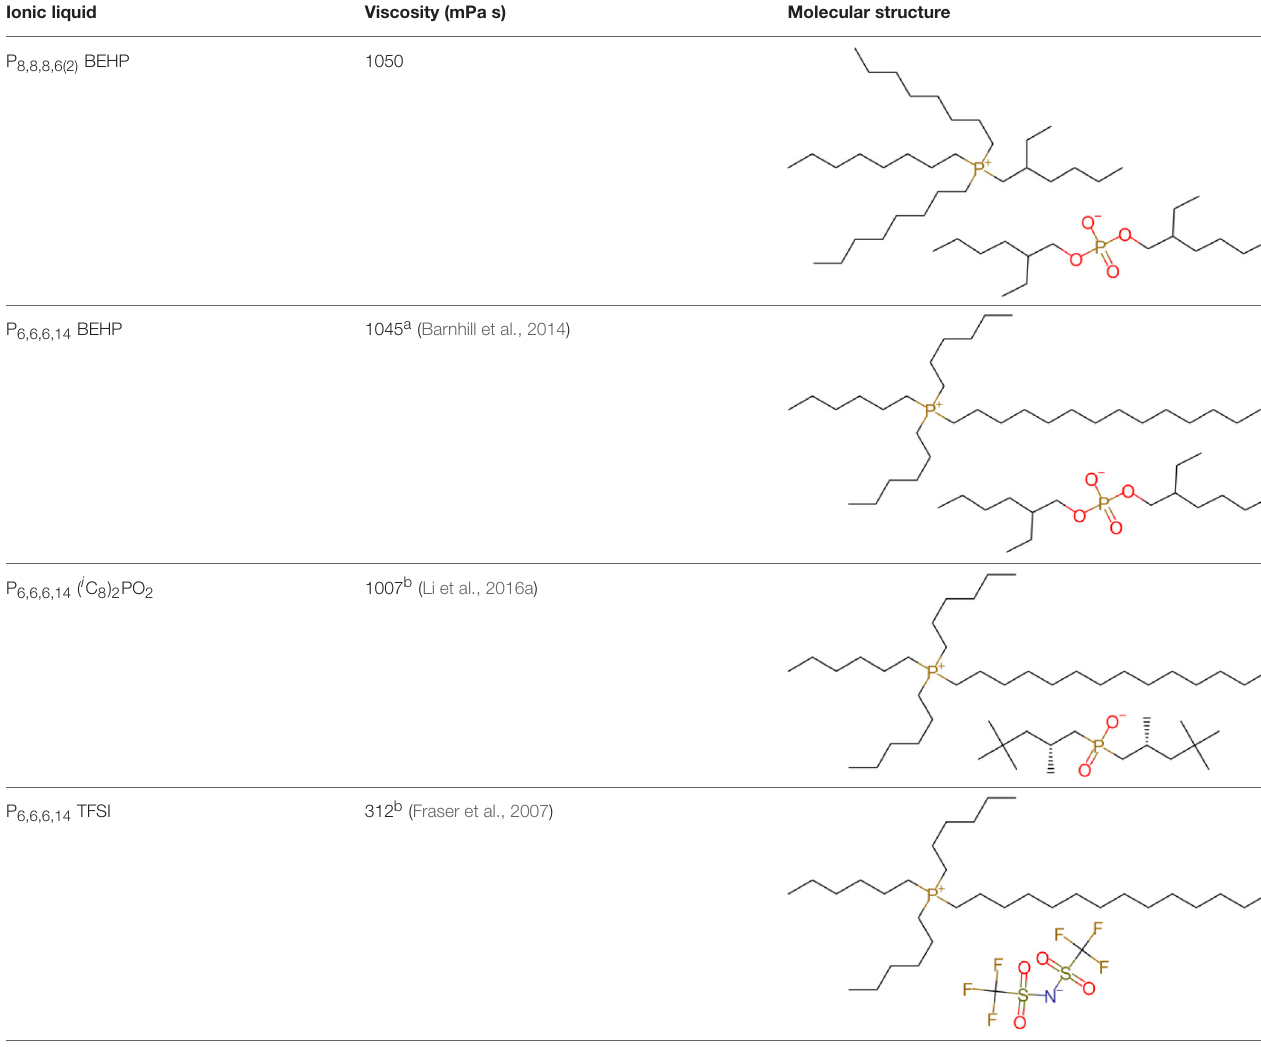
TABLE 1 | The viscosities and molecular structures of the ILs used in this study. Ionic